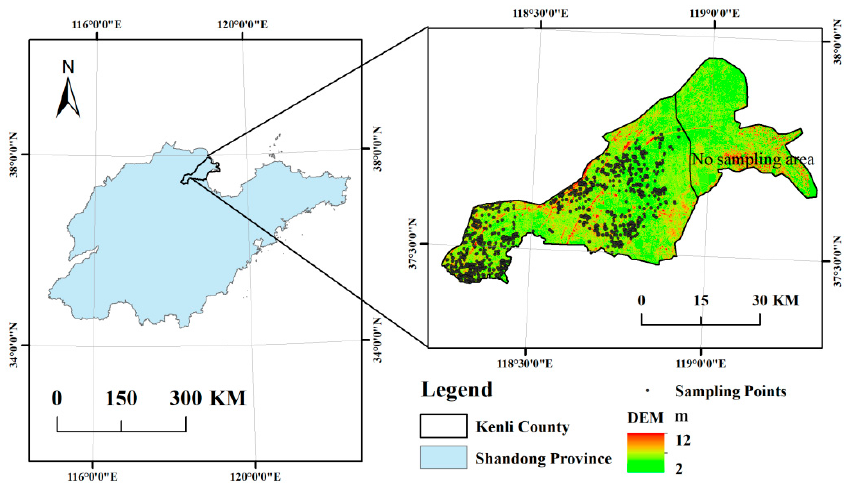
Figure 1. Overview of the study area.